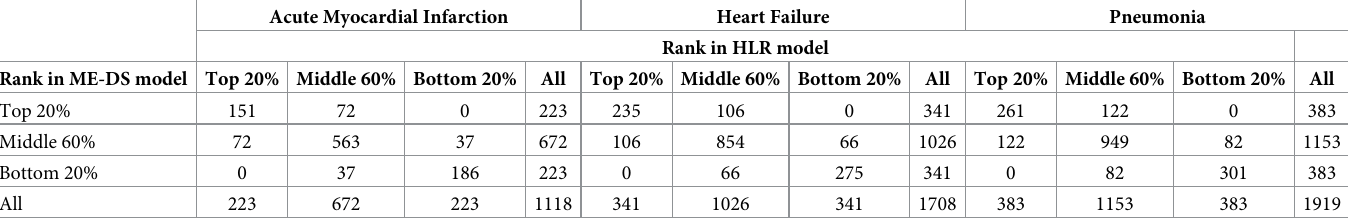
Table 3. Cross tabulation of divided groups between the Hierarchical Logistic Regression (HLR) and the medical code embedding deep set architecture (ME-DS) model for each cohort. Acute Myocardial Infarction Heart Failure Pneumonia Rank in HLR